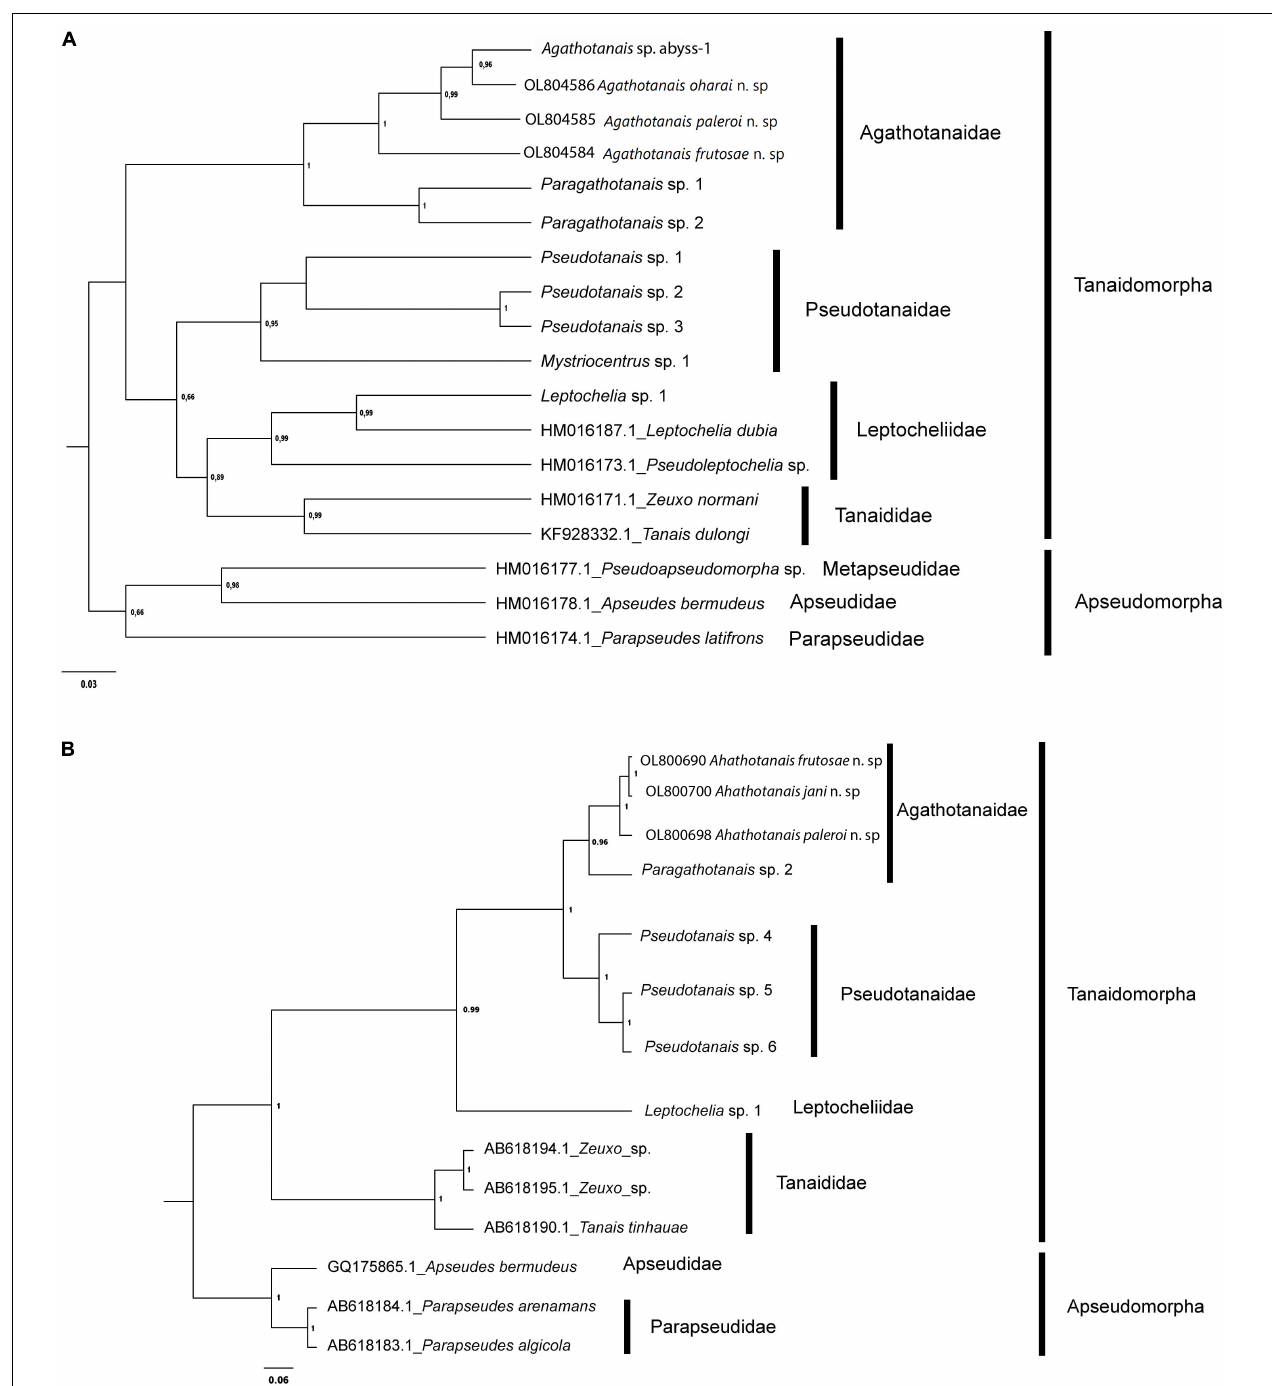
FIGURE 1 | Evolutionary relationships of Agathotanaidae species inferred by using the Histone H3 (A) and 18S (B) sequences and the Maximum Likelihood method. The percentage of trees in which the associated taxa clustered together (bootstrap support) is shown next to the branches. Only values above 0.6 are shown.